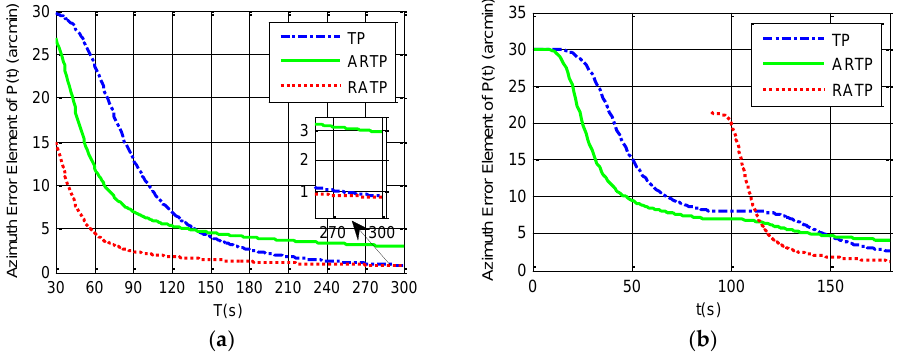
Figure 3. Simulation results under angular vibrations with an amplitude of 10 arcsec and a random frequency between 5 and 10 Hz. ( a ) 1 − σ final azimuth error when the total alignment time T changes from 30 to 300 s. ( b ) Azimuth error curve when the total alignment time is 180 s.